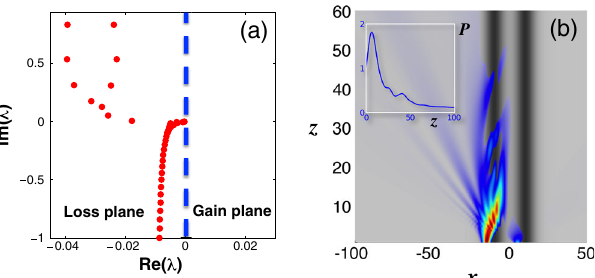
FIG. 2. (a) Eigenvalue spectrum for g ¼ 0 . 5 plotted in the complex plane. (b) Intensity wave dynamics for the intuitive initial conditions. Namely, the light is coupled only at the gain regions. For that initial condition, the inset depicts the optical power versus the propagation distance z . The two black regions represent the two waveguides, and the inset represents the power versus the propagation distance z